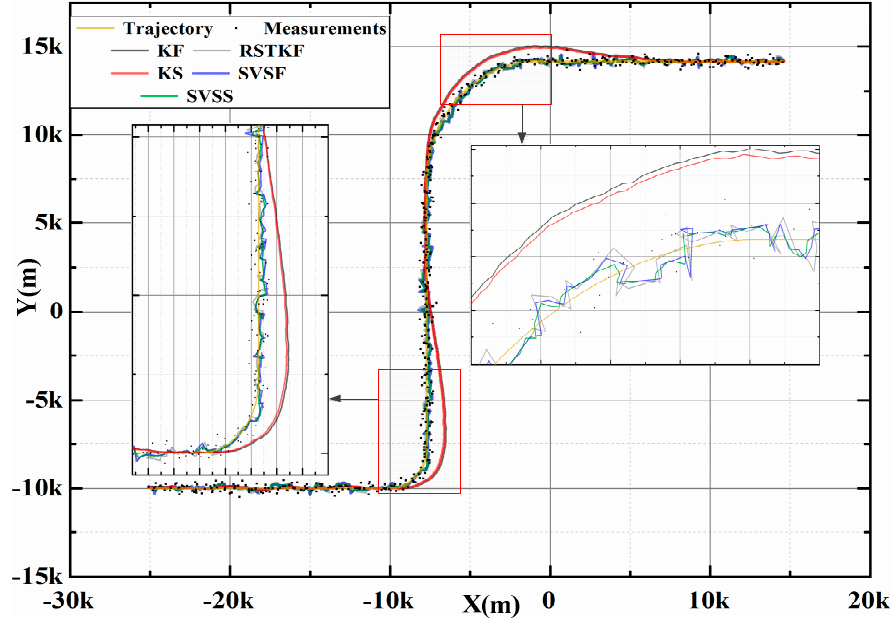
Figure 4. Position trajectory of one experiment.